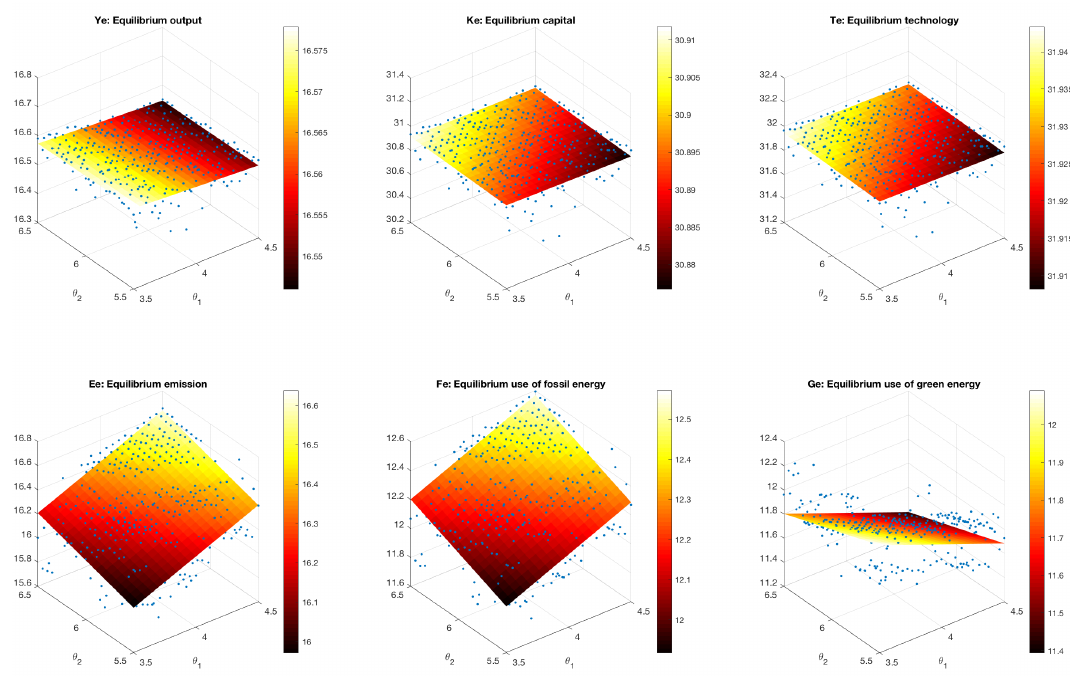
Figure A3. Equilibrium values on grid, non-OECD countries: fitted plane.